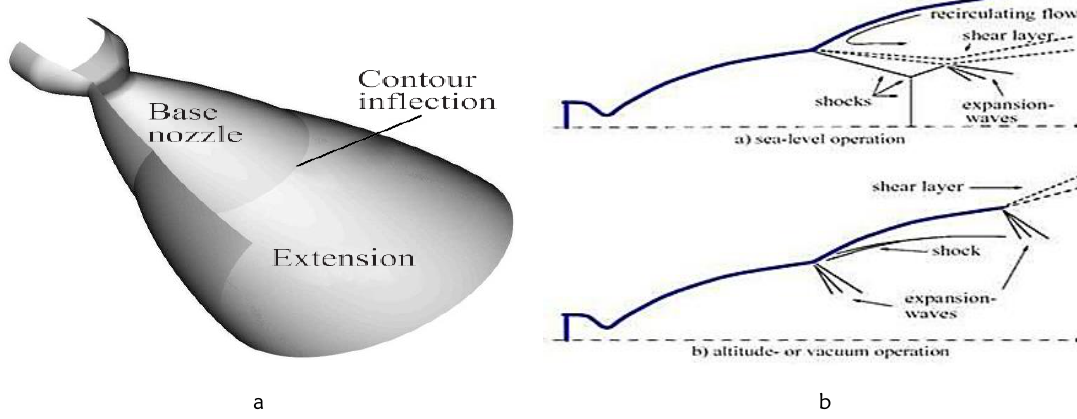
Figure 1: (a) Dual-bell nozzle (b) two operating modes: sea level (top) and altitude mode (bottom) [2]